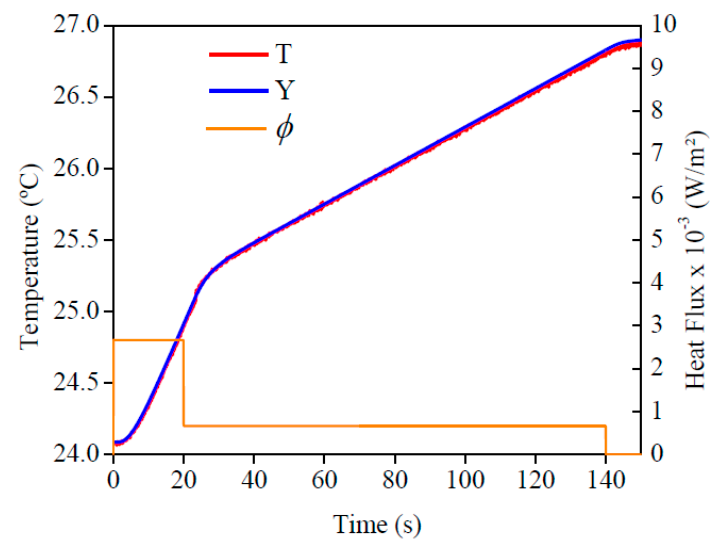
Figure 13. Experimental heat flow ( φ ) for AISI 304. Comparison of temperatures obtained numerically ( T ) and experimentally ( Y ).